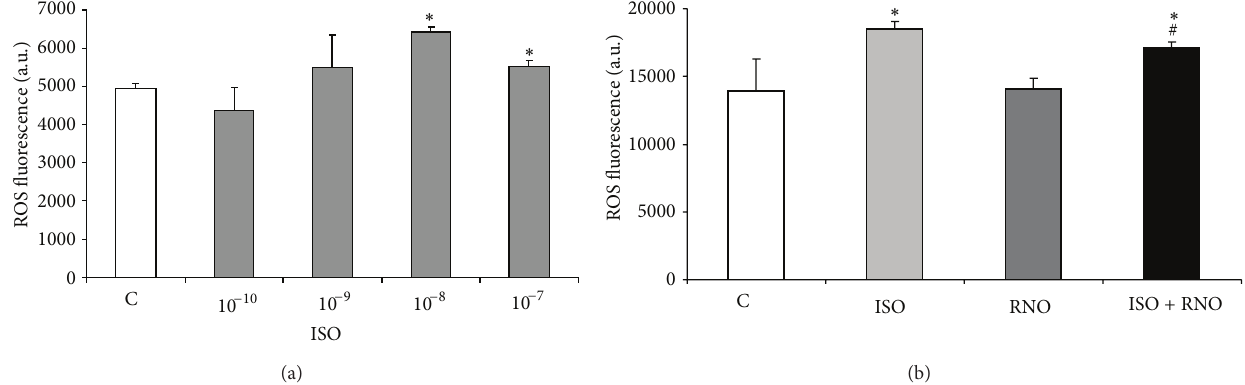
Figure 6: Effect of 8-epi-PGF 2𝛼 (ISO) and RNO on ROS production by HLF. (a) HLF were treated for 24h with various concentrations of 8-epi-PGF 2𝛼 . ROS levels were measured as described in Section 2.4. ROS production was determined over a 60 min period. (b) Cells were preincubated for 30min in presence or absence of RNO (2nM) and then treated with 8-epi-PGF 2𝛼 (10 −8 M) for 24 h. The results are expressed as arbitrary units of fluorescence. Data are mean ± SD of 3 experiments. ∗ 𝑃 < 0.05 versus control (C); # 𝑃 < 0.05 versus 8-epi-PGF 2𝛼